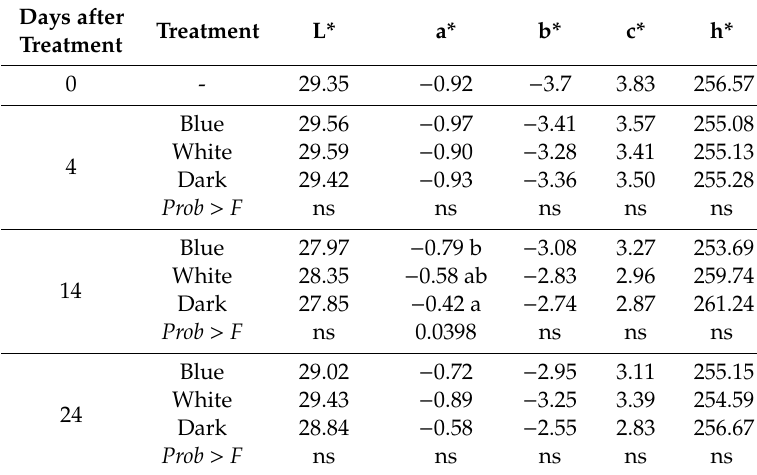
Table 4. Color values in ripe ‘Alapaha’ rabbiteye blueberries subjected to light treatments at various times during cold